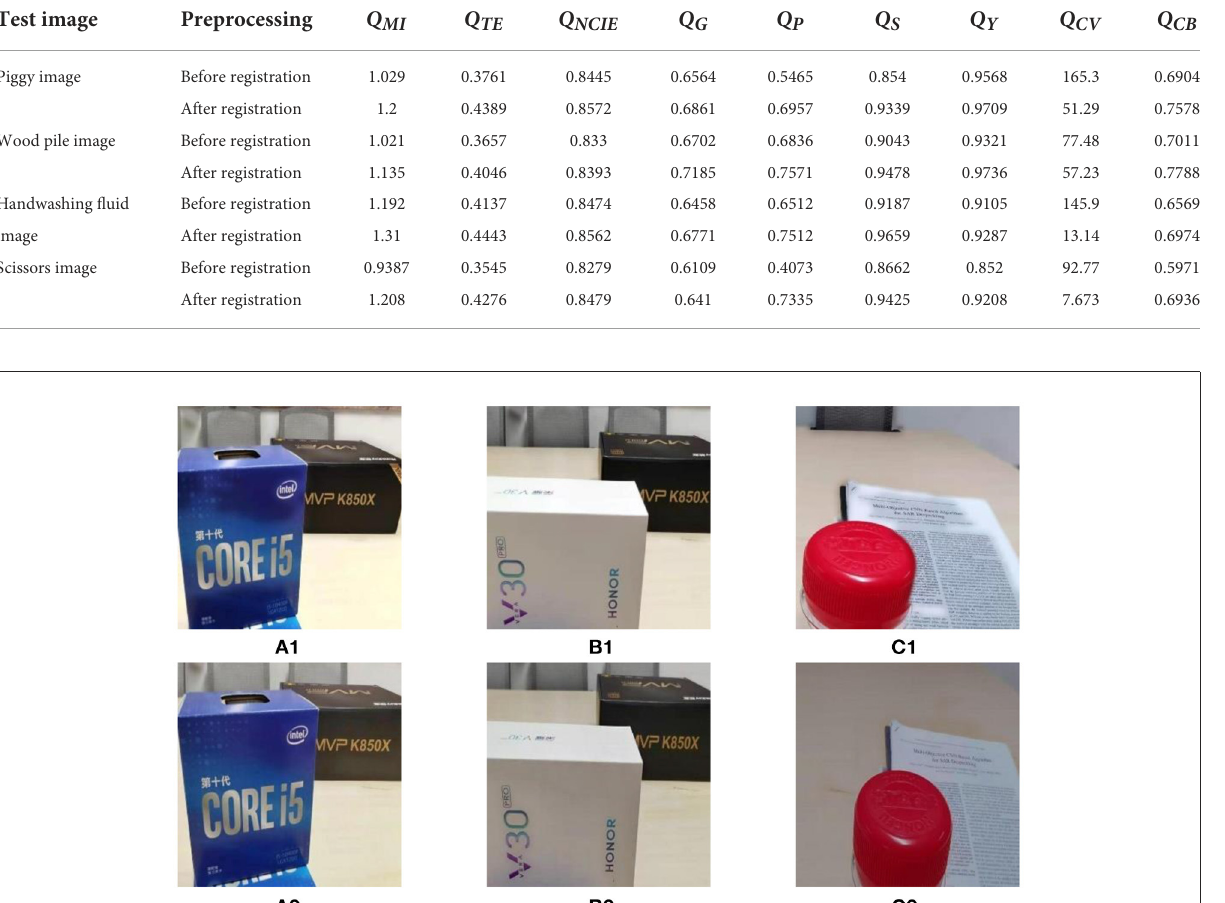
standardization of the image basic attribute. The calculated results of the nine metrics are shown in Table 3,